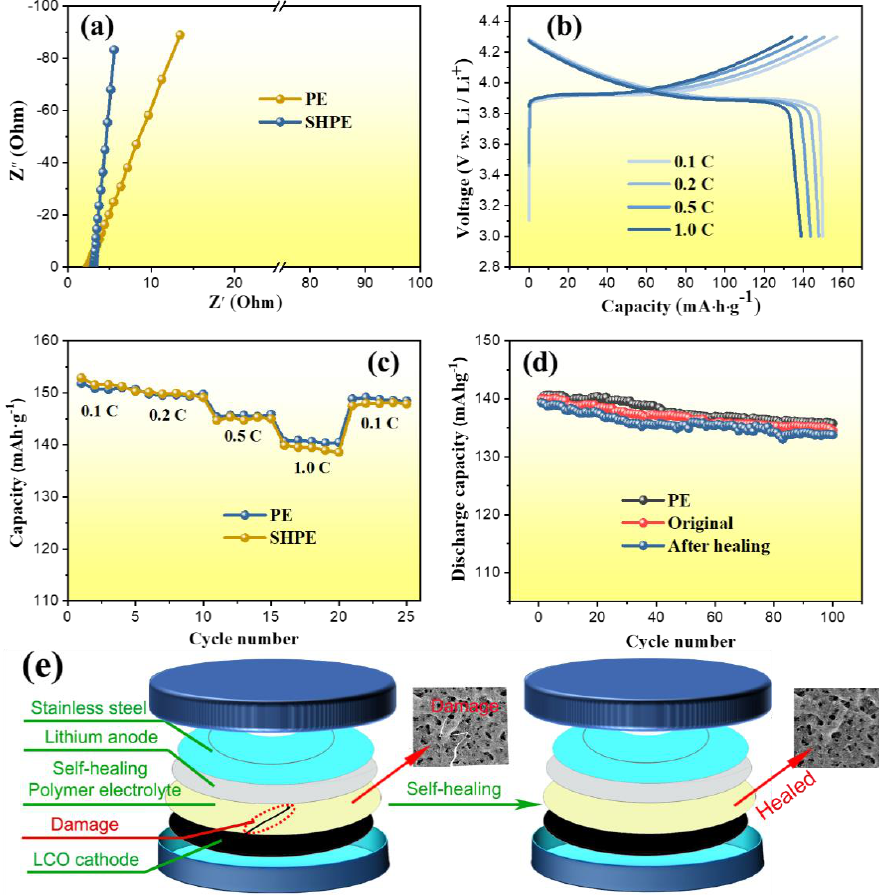
Figure 6. Electrochemical characterizations of the self-healing lithium ion battery. ( a ) Nyquist plots of the SS/SHPEM/SS and SS/PE/SS cells at room temperture. ( b ) Galvanostatic charge-discharge curve tests of PE membrane batteries and SHPE membrane batteries at various C-rates. ( c ) Discharge capacity of a PE membrane and a SHPE membrane cycled at various C-rates. ( d ) Cycling performance of the original SHPE membrane, healed SHPE membrane and PE membrane cycled at 1 C rate. All cells were charged to 4.3 V and discharged to 3.0 V. ( e ) The schematic of the damaged and healed SHPE membrane of lithium battery.